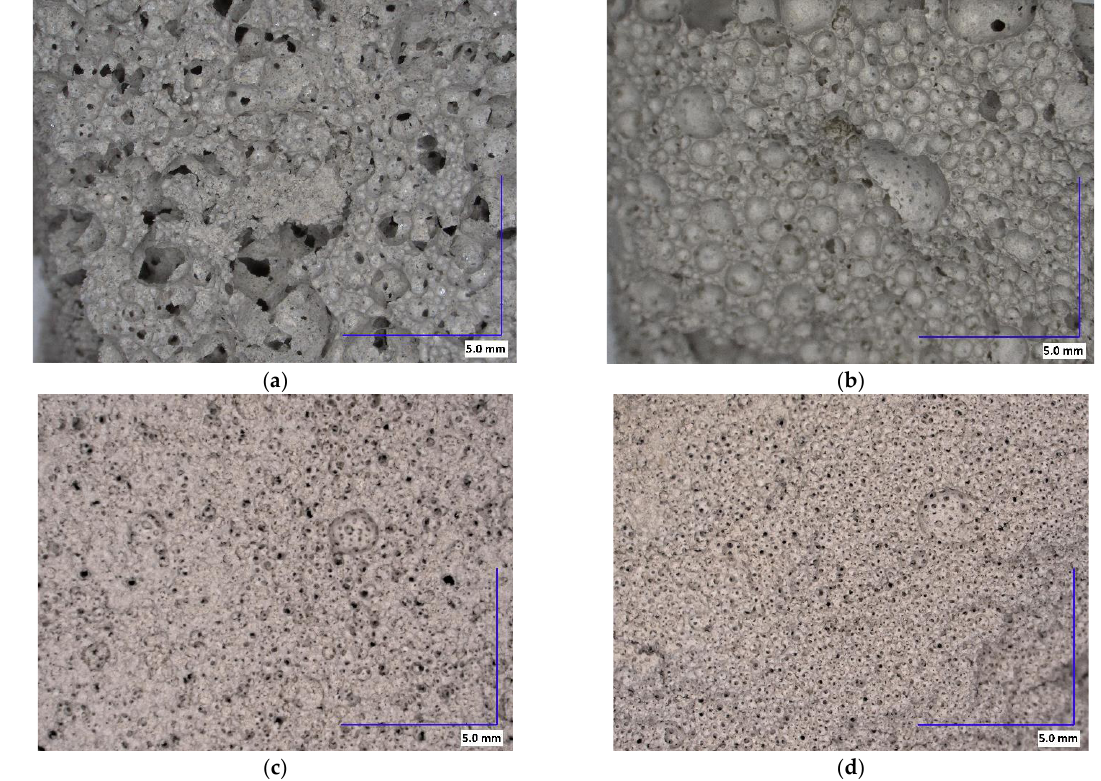
Figure 8. Microscopic photos of the foam concrete with metakaolin and synthetic foaming agent with different densities: ( a ) OPC, 200 kg/m 3 ; ( b ) OPC, 380 kg/m 3 ; ( c ) CSA, 200 kg/m 3 ; ( d ) CSA, 380 kg/m 3 (the scale size is shown in the bottom right corner of each photo).